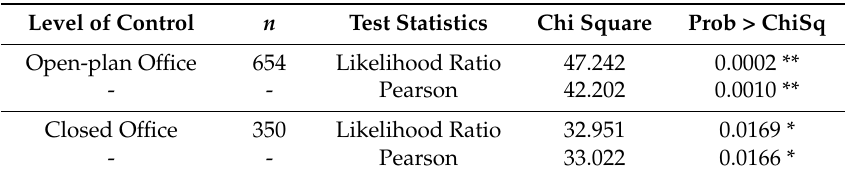
Table 13. Contingency analysis of user satisfaction on temperature by level of control by office type (open-plan vs. closed office).